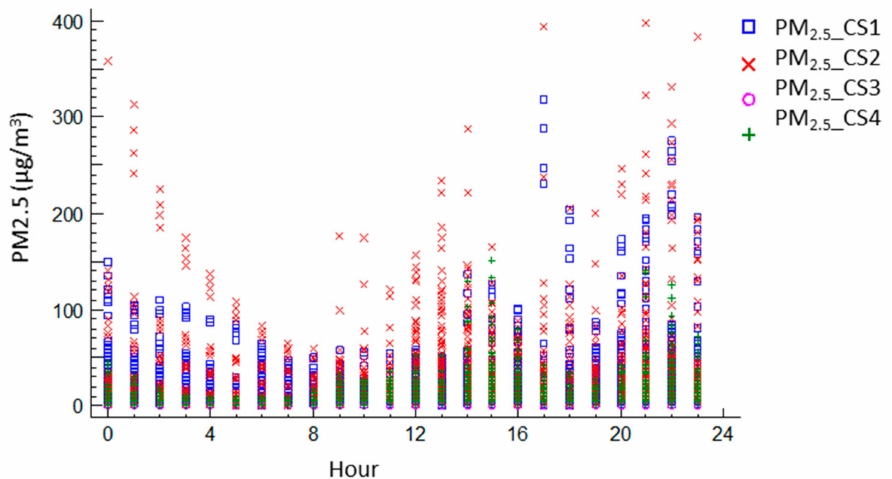
Figure 12. Hourly evolution of the PM 2.5 of the case studies during the lockdown in